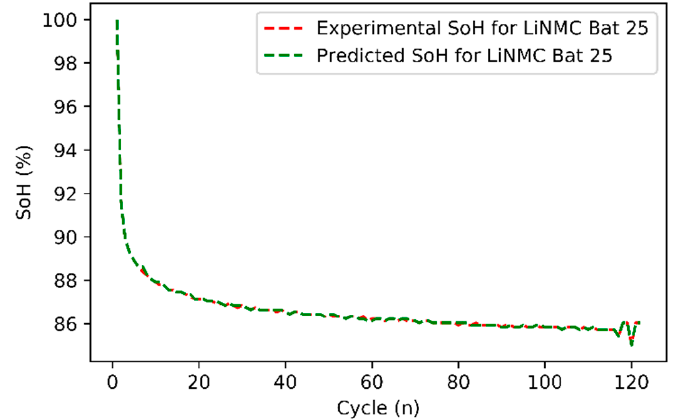
Figure 6. The SOH prediction of battery 25.